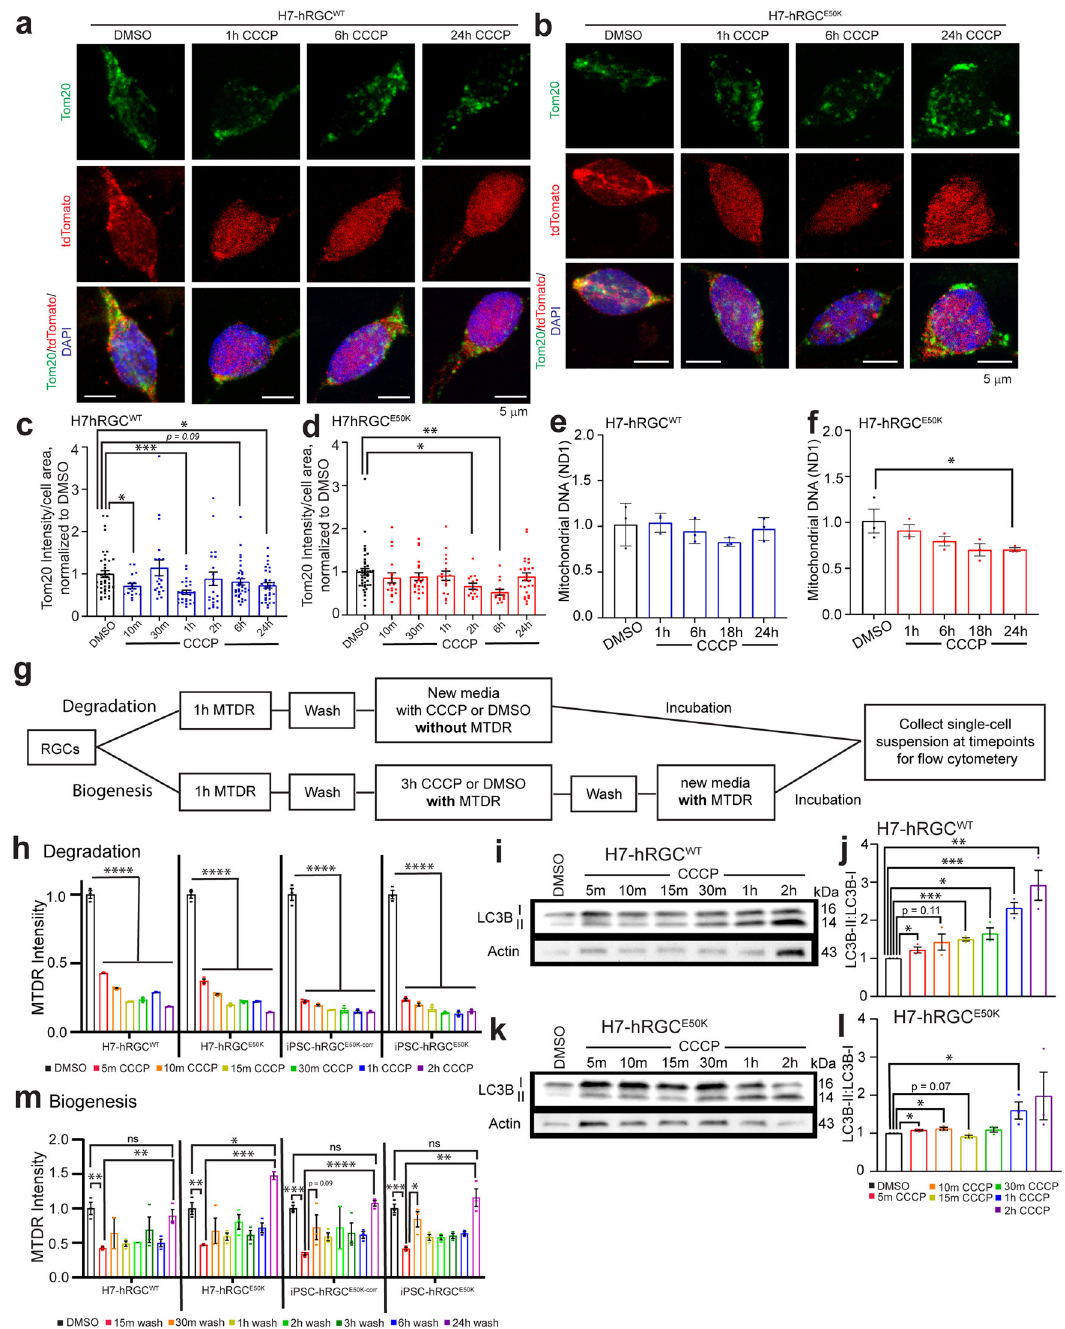
Fig. 1 hRGCs maintain mitochondrial mass by simultaneous degradation and biogenesis of mitochondria under damage. a , b Representative confocal immuno fl uorescence images of H7-hRGCs against mitochondrial Tom20, tdTomato, and DAPI after indicated 10 μ M CCCP treatment timepoints. Scale bars are 5 μ m. c , d Quanti fi cation of Tom20 intensity per cell area from sum projections of confocal z-stacks, normalized to corresponding DMSO. n = 14 – 42 cells per condition. e , f Mitochondrial DNA copy number analyzed by qPCR for mitochondrial ND1 gene relative to nuclear RNase P. Results shown as ΔΔ Ct fold changes relative to DMSO control for different times points of 10 μ M CCCP treatment. n = 3, 3 technical repeats averaged for each biological repeat. g Schematic of MTDR fl ow experiments for tracking degrading versus newly synthesized mitochondria. h Mitochondrial mass in single cells at different CCCP (10 μ M) treatment time points for degradation or m different timepoints post CCCP (10 μ M) wash for biogenesis were measured by fl ow cytometer, and the average fl uorescence intensity normalized to DMSO was plotted. n = 3. i , k Representative western blot images of LC3B and actin from i hRGC WT and k hRGC E50K treated with CCCP (10 μ M) for the indicated timepoints. j , l Quanti fi cation of the ratio of LC3B-II to corresponding LC3B-I for each condition. n = 3. ٭ p -value < 0.05, ٭٭ p -value < 0.01, ٭٭٭ p -value < 0.001, ٭٭٭٭ p -value < 0.0001. Unpaired student ’ s t-test between independent datasets. Error bars are